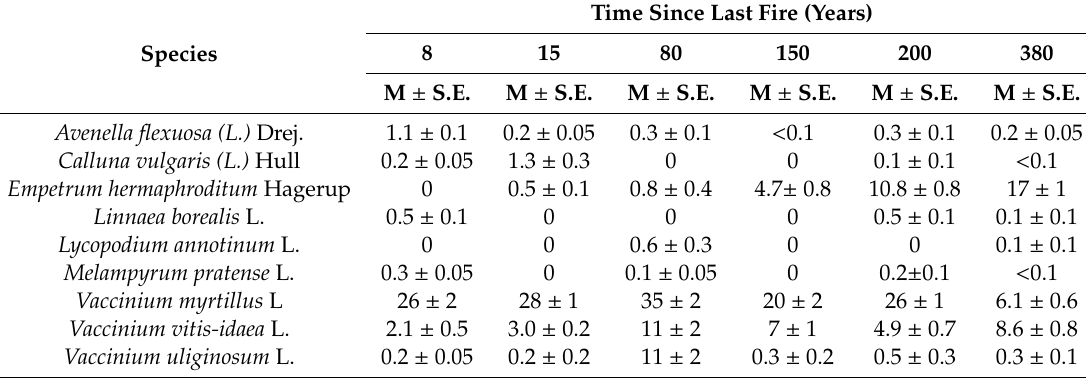
Table 5. Cover of dwarf shrub and herb layer species in forests with different post-fire periods.